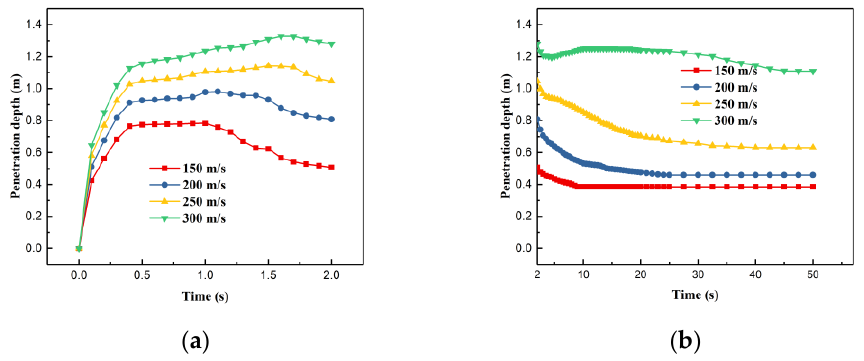
Figure 2. Evolution of penetration depth in the raceway: ( a ) 0–2 s and ( b ) 2–50 s.